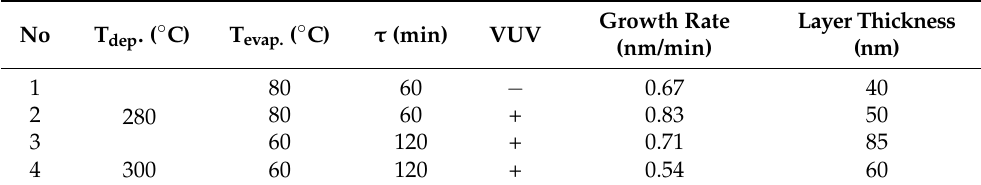
Table 2. Deposition conditions, growth rate and coating thickness of the samples of compact iridium layers on